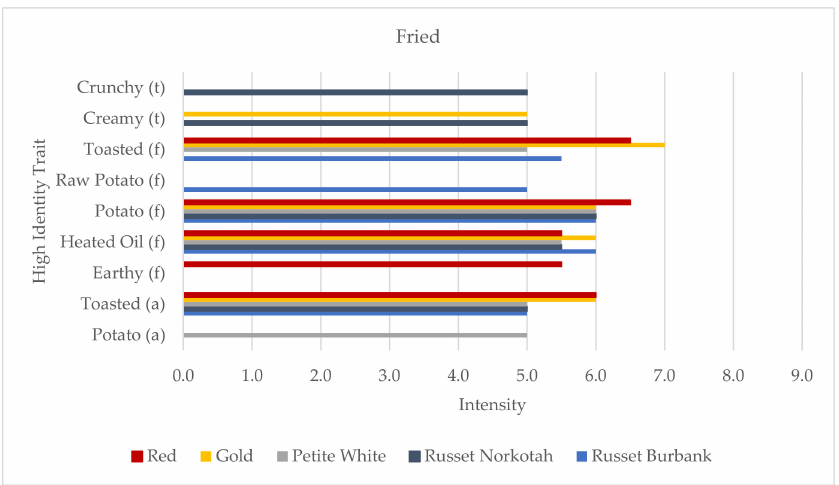
Figure 4. High identity traits (HITs) profiles of the fried potato samples (aroma (a) the “smell” of the product; flavor (f), tastes, aromatics, and feeling factors while food is being eaten by the mouth; and texture (t)). Intensity was rated on a 0–15 scale with 0.5